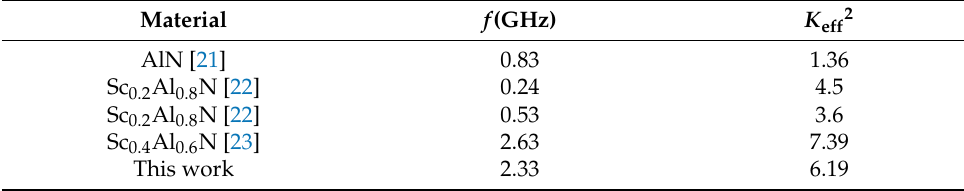
Table 2. Comparison of previous work with K eff2